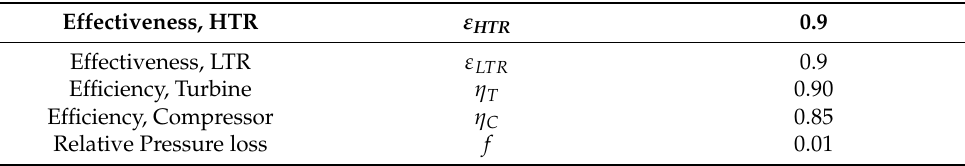
Table 2. Component parameters used for the cycle simulation